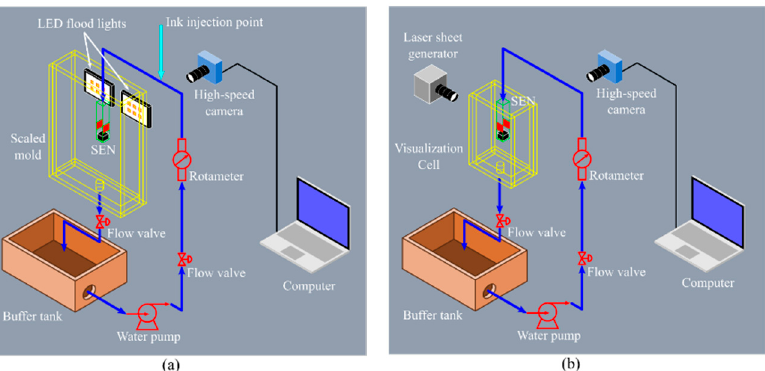
Figure 2. Schematic representation on the two experimental configurations studied in this work: ( a ) NIP operating inside a scaled mold model and ( b ) NIP operating inside a visualization cell.